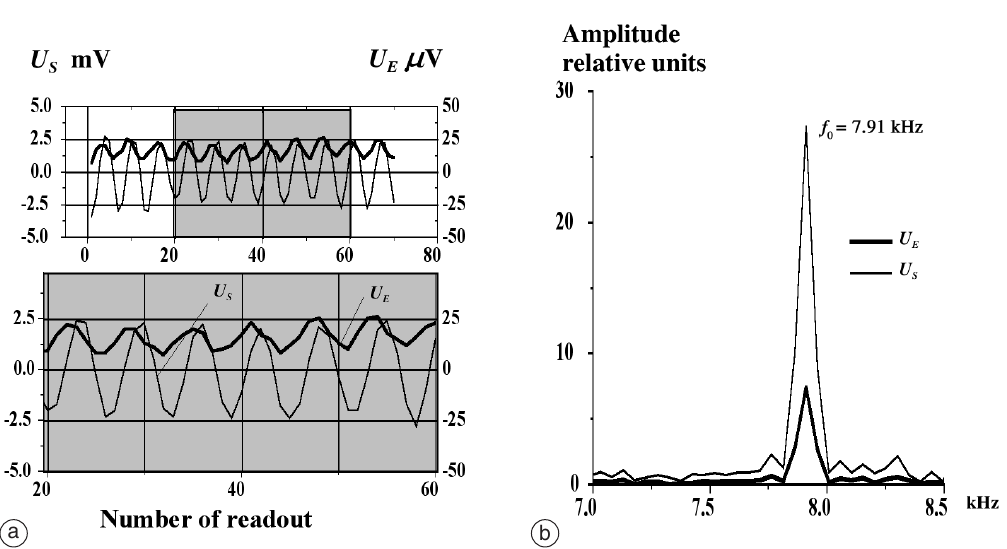
Fig. 8a,b. MSO of the first type, sample’s humidity is increased by 3%: a) electric ( U E ) and acoustic ( U S ) sig- nals; b) spectra of the signals U E and U S